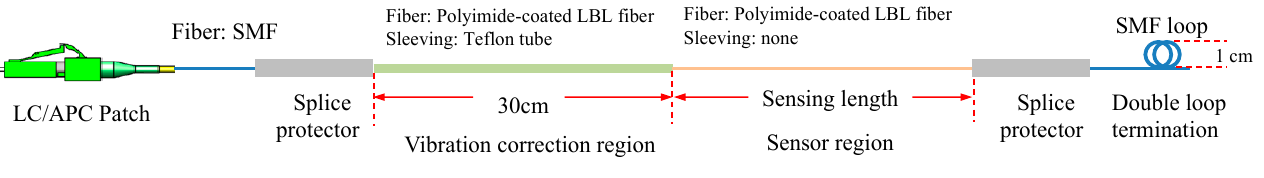
Figure 1. Schematic of an OFDR strain sensor.